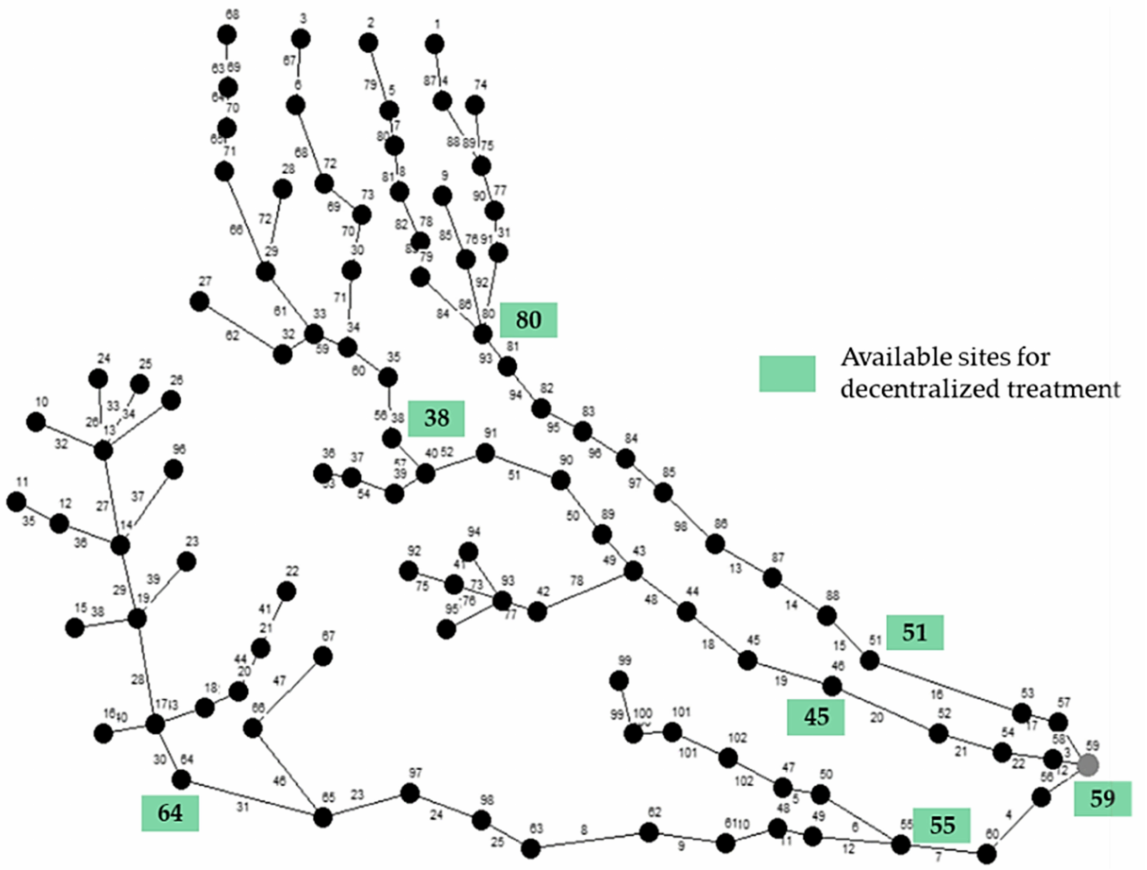
Figure 3. Illustrative wastewater collection system with locations for decentralized treatment